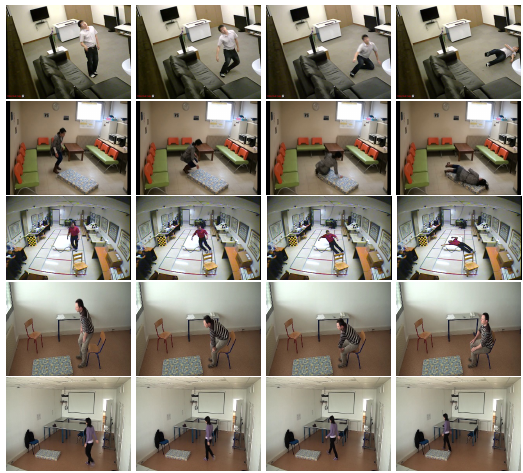
Figure 14. Key frames from several datasets. The fall and normal activities. First row, second and third row show the fall activities from Dataset D3, D4 and D5 respectively. The Fourth and the last row show the sitting and walking activity from the Dataset D2.